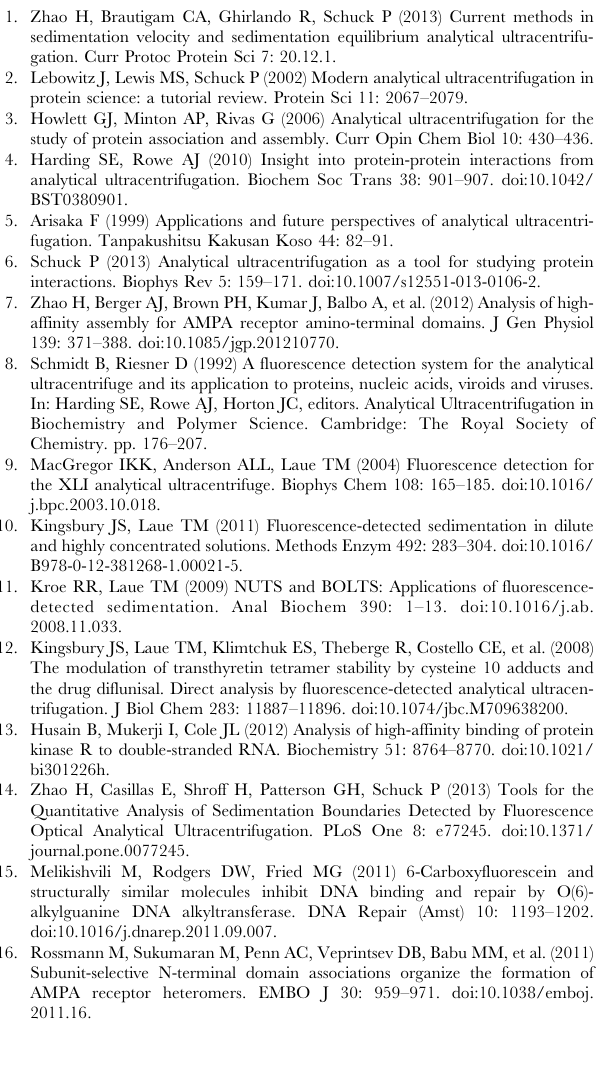
Figure S2 c(s) distributions of FAM-GluA2 ATD in the presence of different concentrations of BSA. For the BSA concentration dependent assay of FAM-GluA2 ATD, the labeled protein with a labeling ratio of 2.26 was used. Two concentrations of FAM- GluA2 ATD (1 nM in Panel A; 100 nM in Panel B) with a range of BSA concentration (0.1, 0.2, 0.5, 1.0 mg/mL) were examined. (TIF)